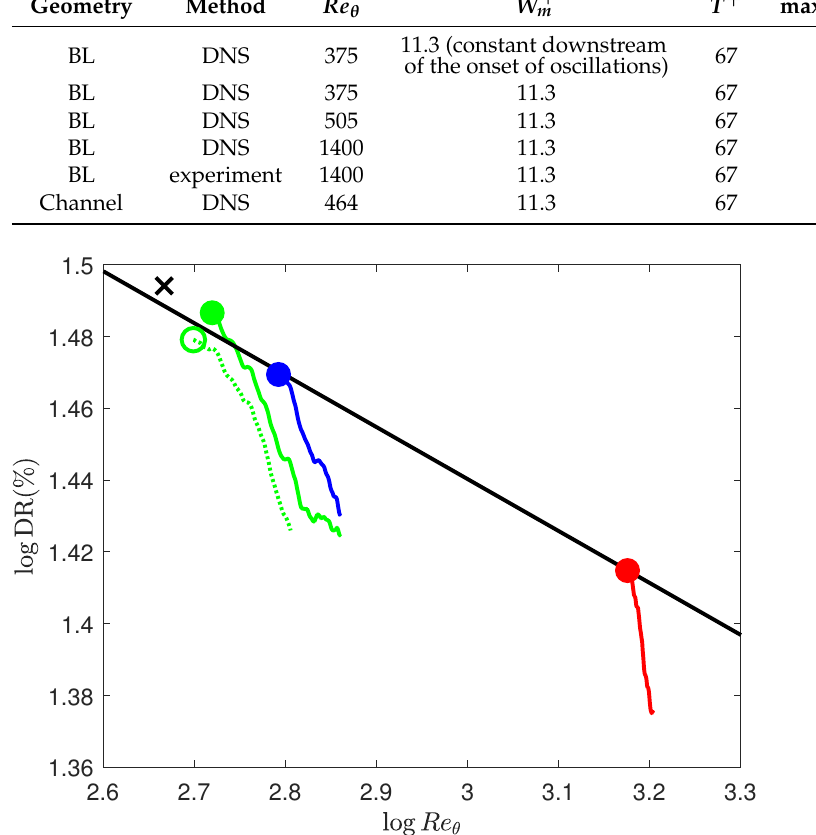
Figure 3. DR for temporal forcing with W + m = 11.3 and T + = 67 at various Reynolds numbers. Re θ = 1400 (red); Re θ = 505 (blue); Re θ = 375 (green). Also, the case with varying W m (constant W + m = 11.3) is included (green, broken). Circles show maximal values of DR (DR max ) , while lines leaving these circles demonstrate dependence of DR on the Reinolds number. Black line is relation DR max ( % ) ∝ Re − 0.153